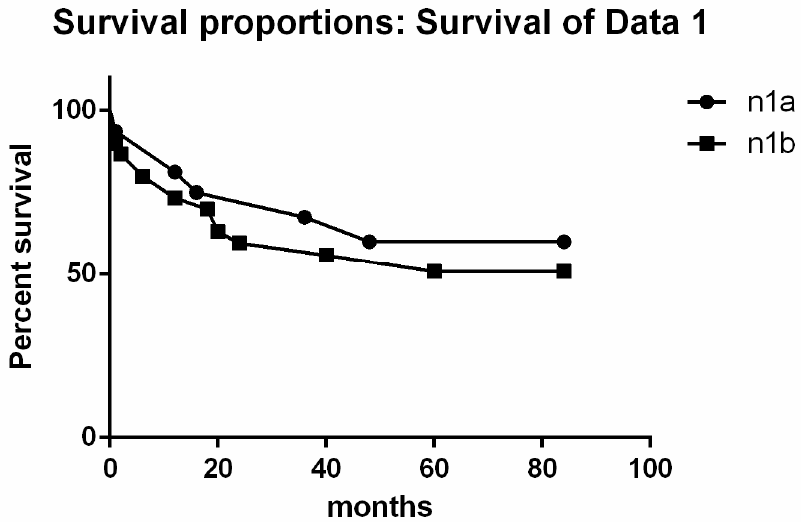
Figure 3. ( a and b ): ( a ): Distribution of thyroid cancer histotypes and disease-free survival (Figure 3a); ( b ): distribution of thyroid cancer histotypes and survival proportions.